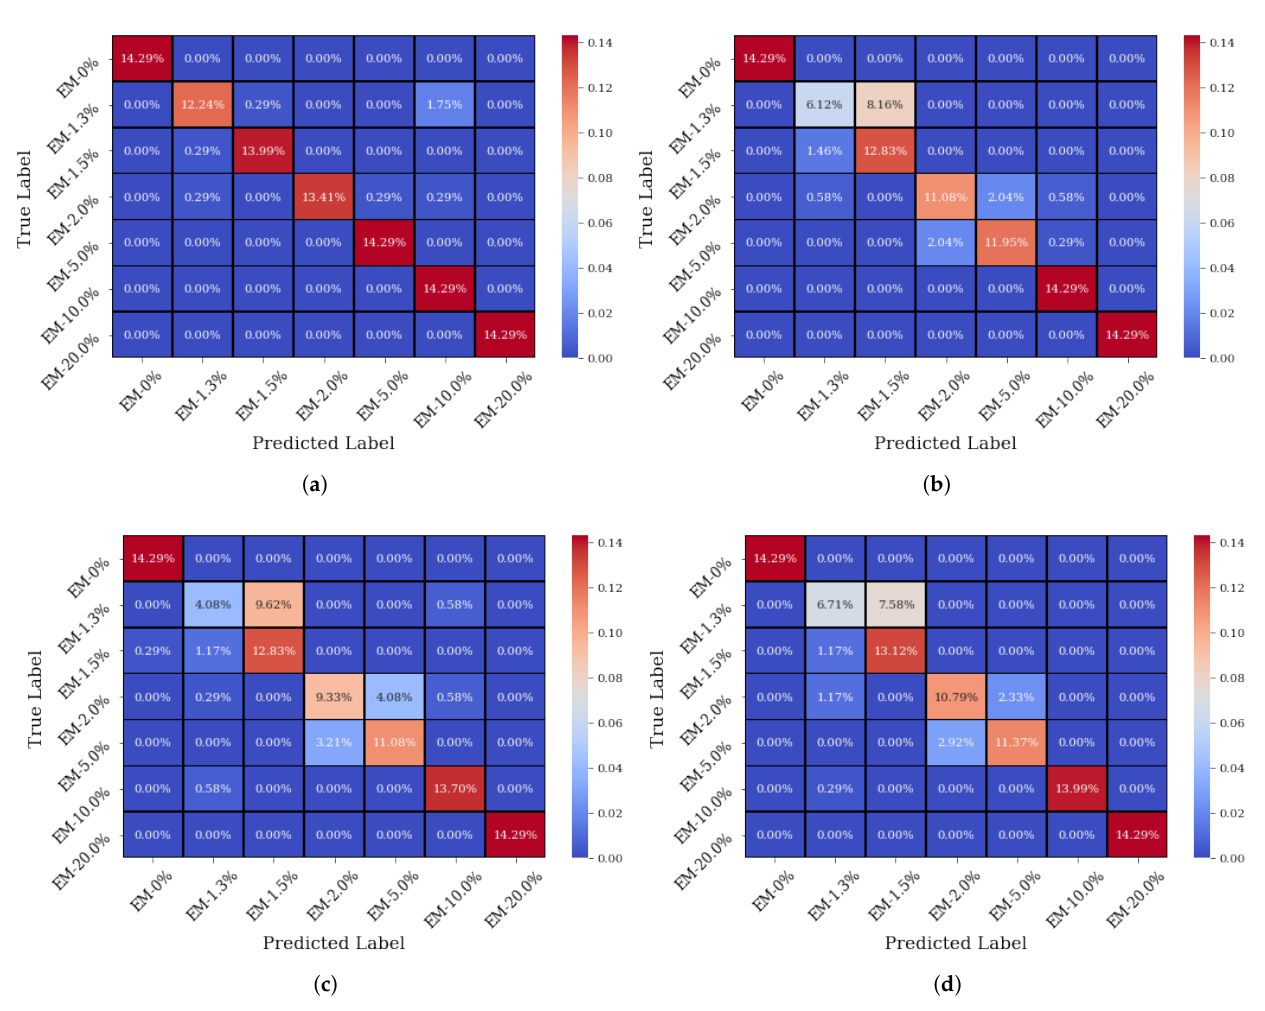
Figure 9. Confusion matrices on test samples from ( a ) CNN ( b ) LSTM ( c ) GRU and ( d )